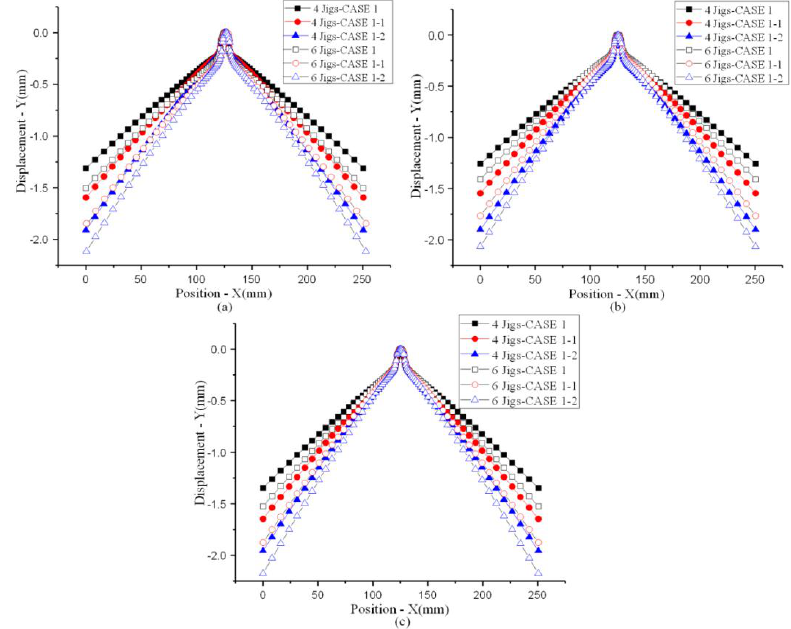
Figure 16. Y-deformation using an applied jig fixture with a depressed displacement of 0 mm, 0.05 mm, and 0.1 mm: ( a ) line 1; ( b ) line 2; ( c ) line 3.